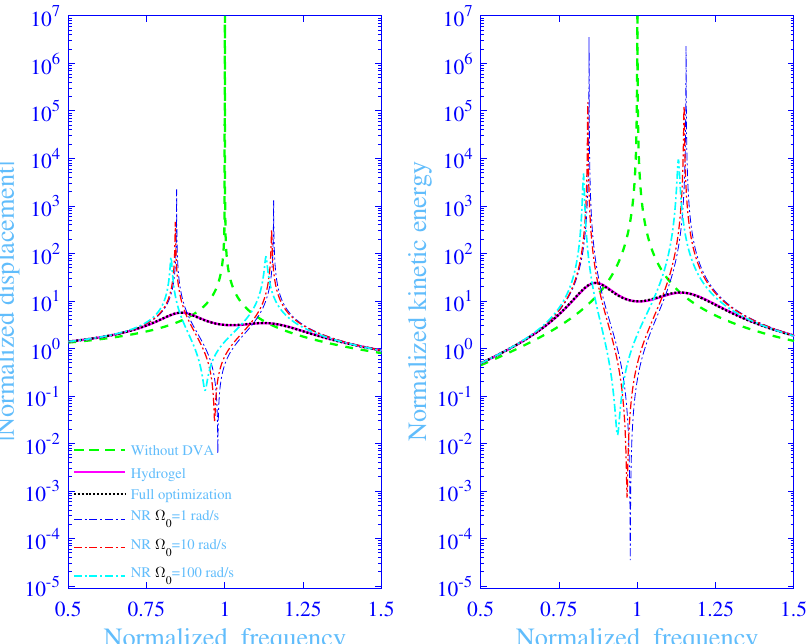
Figure 6. Absolute value of the normalized displacement and the normalized kinetic energy of the mass M versus the normalized frequency with and without the dynamic vibration absorber (DVA) together with the absolute value of the normalized displacement of the mass m versus the normalized frequency, for the hydrogel and the natural rubber dynamic vibration damping at various natural frequencies for the primary vibration system Ω 0 , with α = 0 and χ =